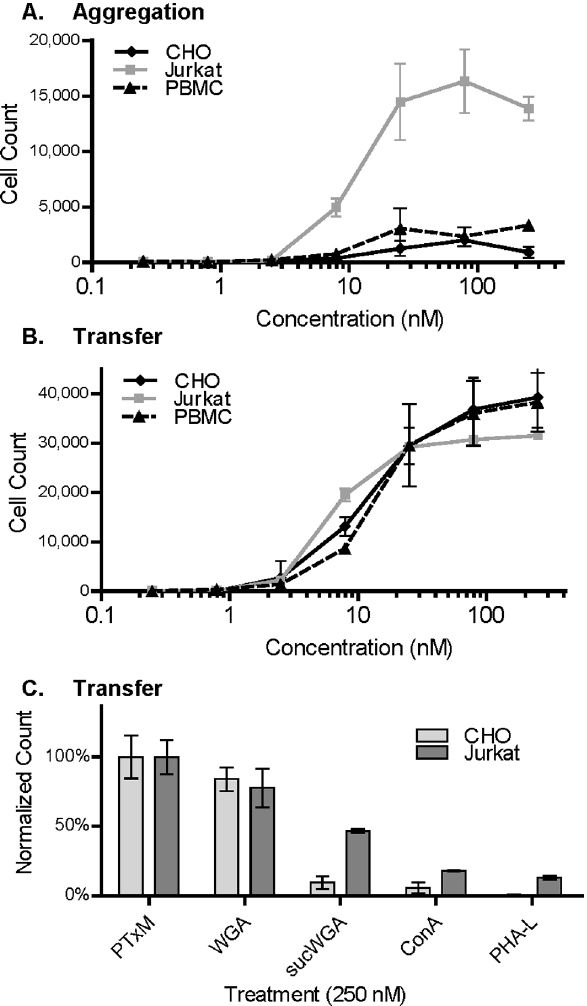
Figure 9. Effects of PTxM or lectin treatment on CHO cells, Jurkat cells, and PBMCs. Cells were treated with the indicated concentrations of PTxM or lectins for 1 hr on ice, and the number of cell aggregates ( A ) and cells demonstrating membrane transfer ( B, C ), were determined by flow cytometry. Results represent the mean of three independent assays with standard deviation. In C , membrane transfer population sizes for lectin treatment were normalized to the mean PTxM transfer population size for each cell type.